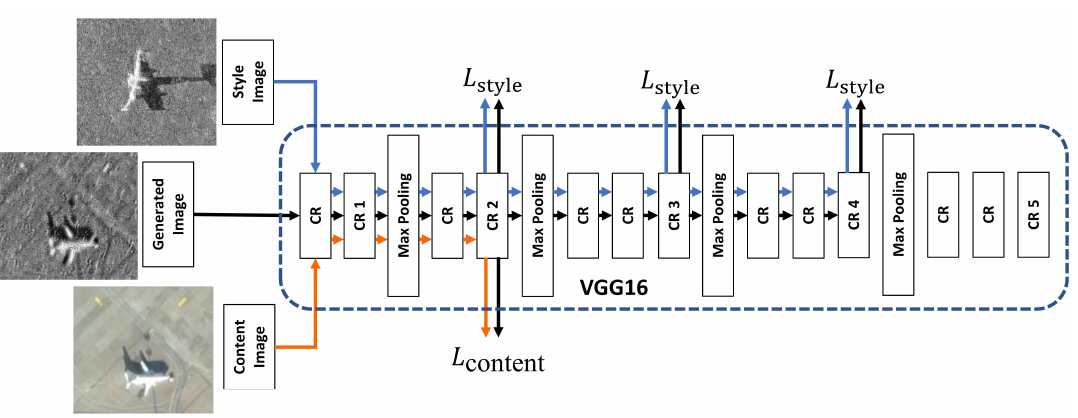
Figure 6. One loop of image ST with VGG16 (generated image is random noise before the first loop).